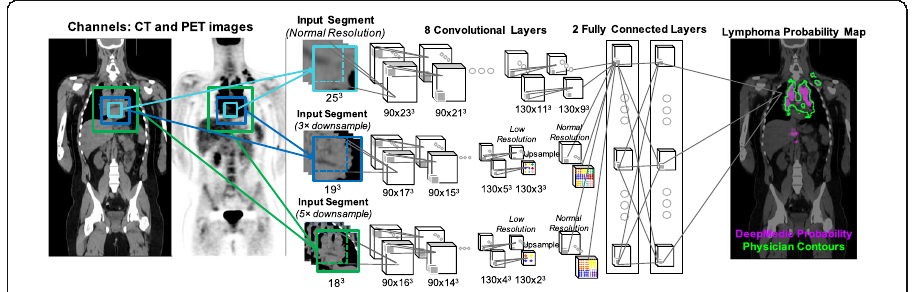
Fig. 1 DeepMedic network design, adapted for lymph node detection. The number of features in all convolutional layers was 90, 90, 110, 110, 110, 110, 130, and 130. The number of features in the two fully- connected layers was 250. The input segment size of the downsampled pathways are set so that the feature maps prior to the final connected layer are of equivalent size, as in